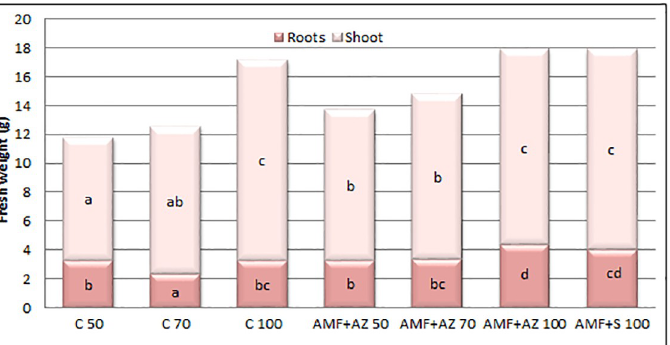
Fig 1. Effects of soil microorganisms application on fresh weight of tomato shoots and leaves. Means followed by different letters are significantly different at p � 0.05, with comparisons performed by Fisher’s LSD test, separately for roots and shoots. C 50 –peat:sand ratio 50:50 (v:v) without inoculation; C 70 –peat:sand ratio 70:30 (v:v) without inoculation; C 100 ––peat:sand ratio 100:0 (v:v) without inoculation; AMF + AZ 50 –peat:sand ratio 50:50 (v:v) inoculated with arbuscular mycorrhizal fungi (AMF) and Azospirillum brasilense (AZ), AMF + AZ 70 ––peat:sand ratio 70:30 (v:v) inoculated with AMF and AZ, AMF + AZ 100 –peat:sand ratio 100:0 (v:v) inoculated with AMF and AZ; AMF + S–– 100 peat:sand ratio 100:0 (v:v) inoculated with AMF and Saccharothrix tamanrassetensis